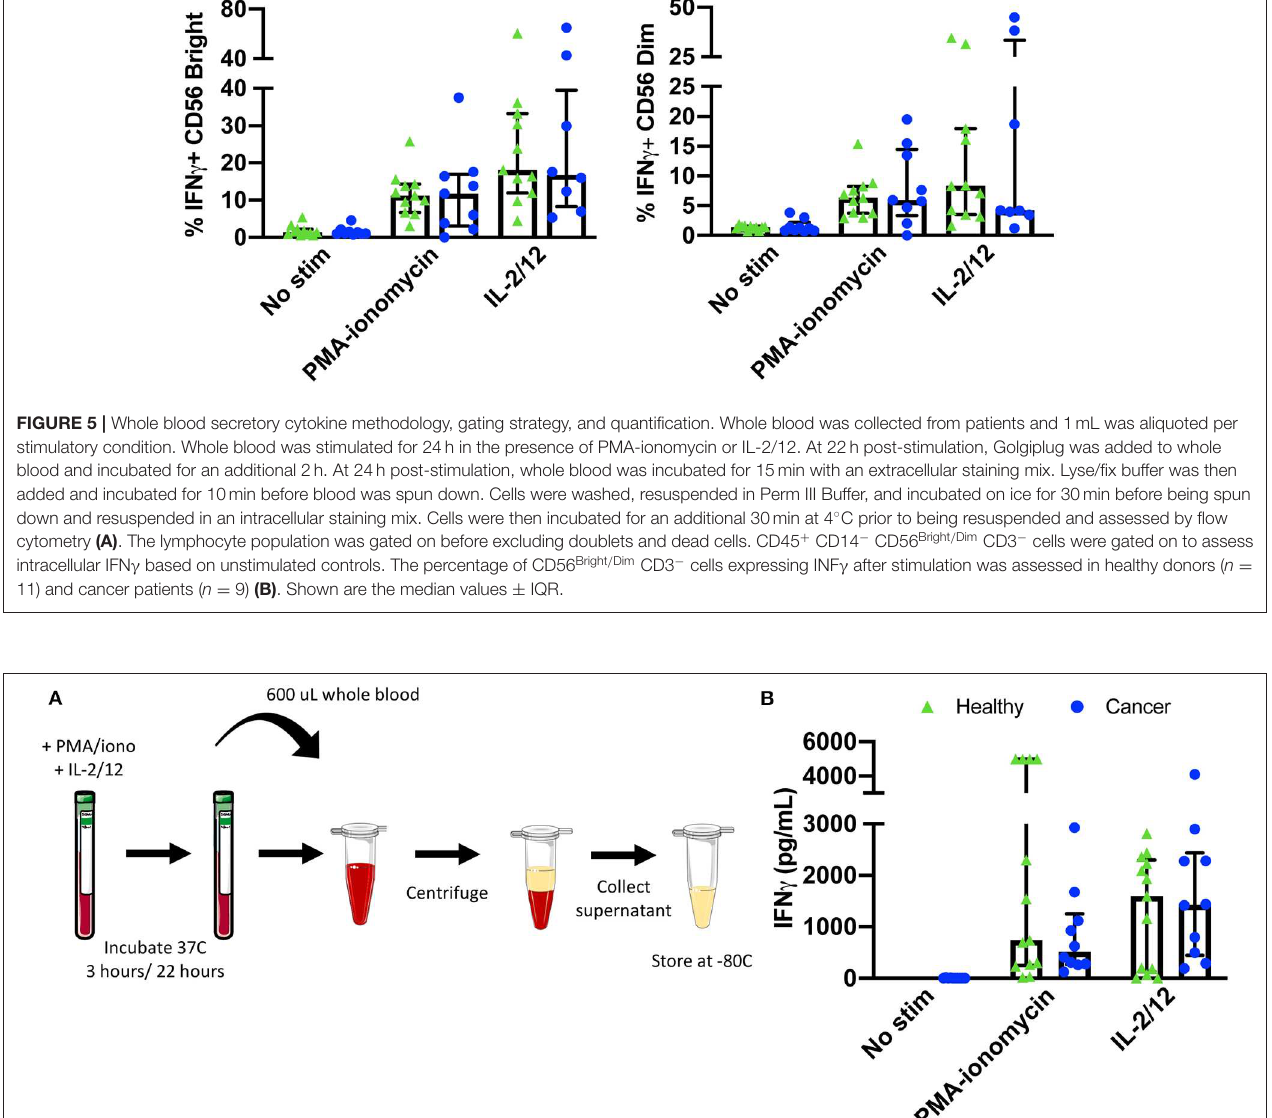
Frontiers in Immunology |